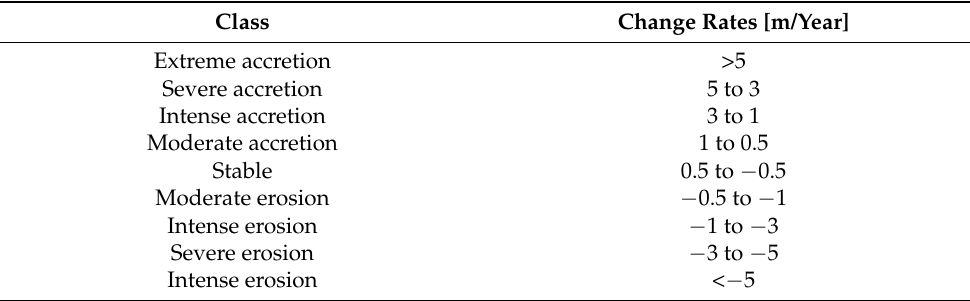
Table 2. Coastline change classification scheme on Level 2.